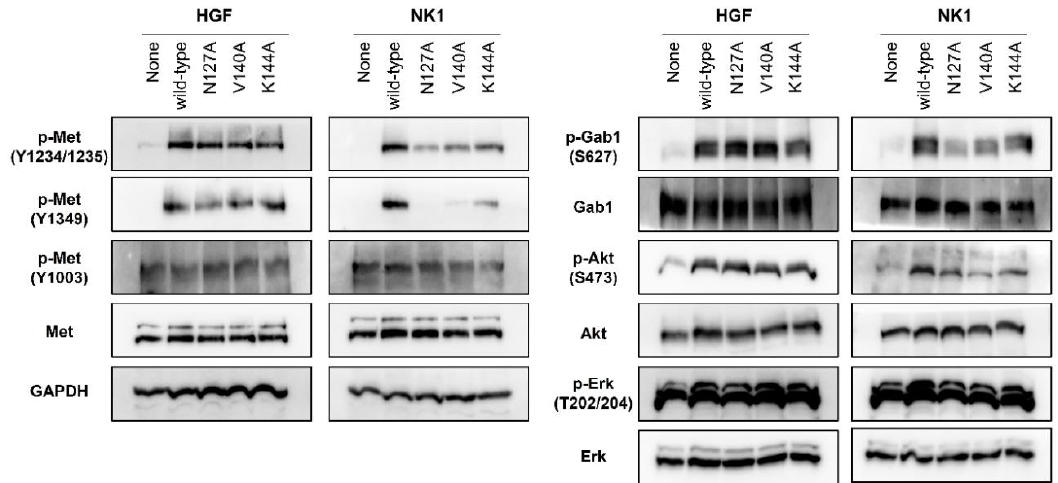
Figure 3. Phosphorylation profiles of Met signaling pathway by wild-type and mutant NK1 or HGF proteins. Serum-starved EHMES-1 cells were stimulated with the recombinant proteins and 5% fetal bovine serum for 10 min. Phosphorylated individual residues of Met receptors, Gab1, Akt, and Erk were detected by Western blotting. GAPDH (glyceraldehyde-3-phosphate dehydrogenase) was monitored to ensure equal loading. This experiment was performed once.